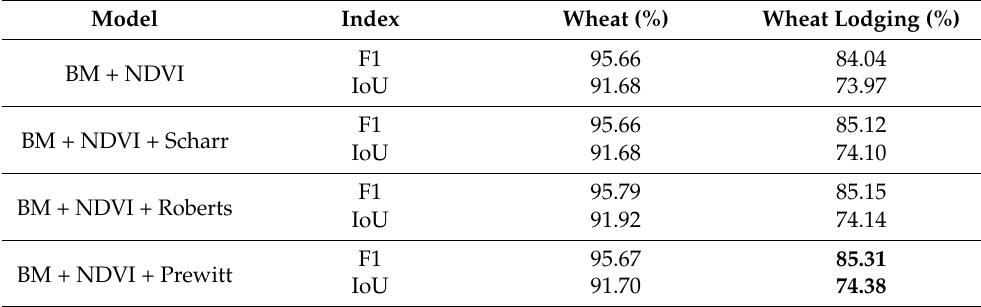
Table 6. Segmentation results comparison of using different edge operators with NDVI on the test